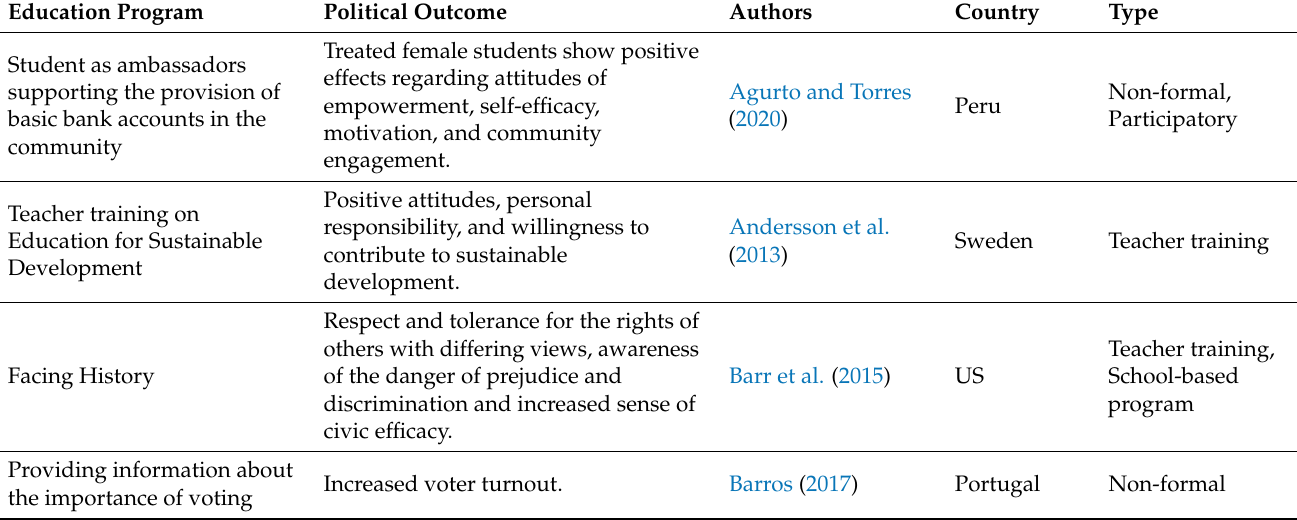
Table 1. Identified control trials of citizenship education for political